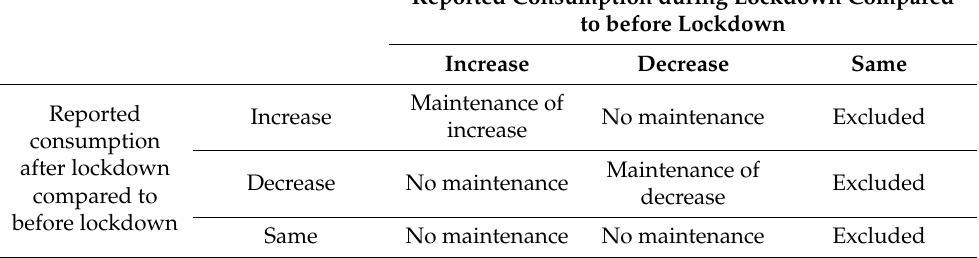
Table 2. Construction of the variable “maintenance of changes” based on reported consumption during and after lockdown compared to before